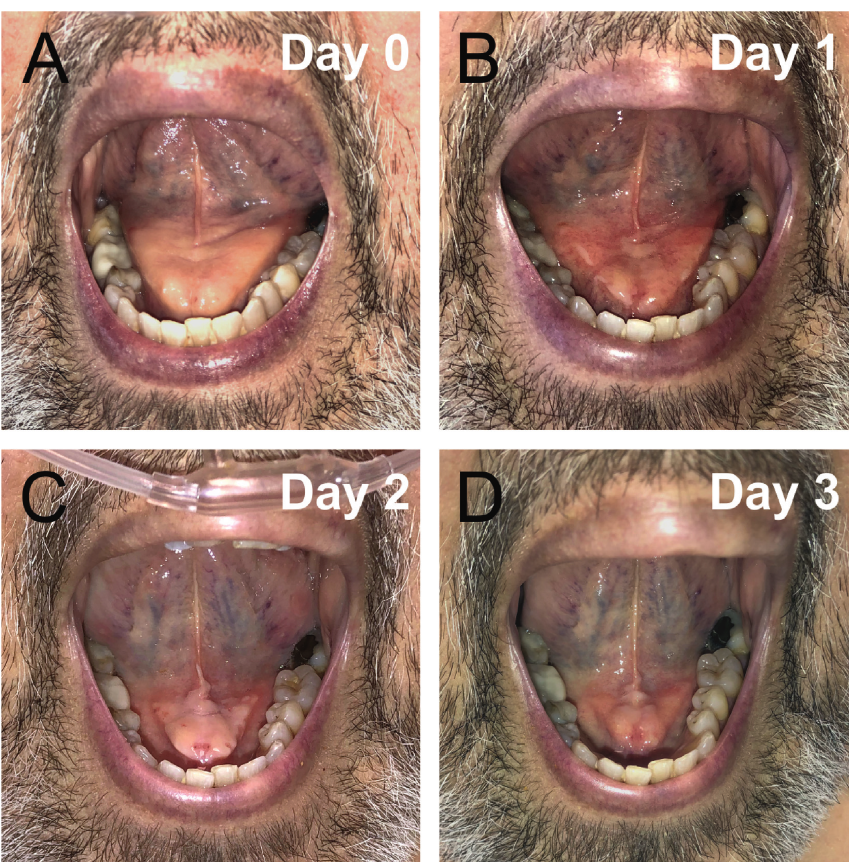
Figure 1: Clinical course of the patient with contrast-induced sialadenitis. (a). Day 0 (b). Day 1 (c). Day 2 (d). Day